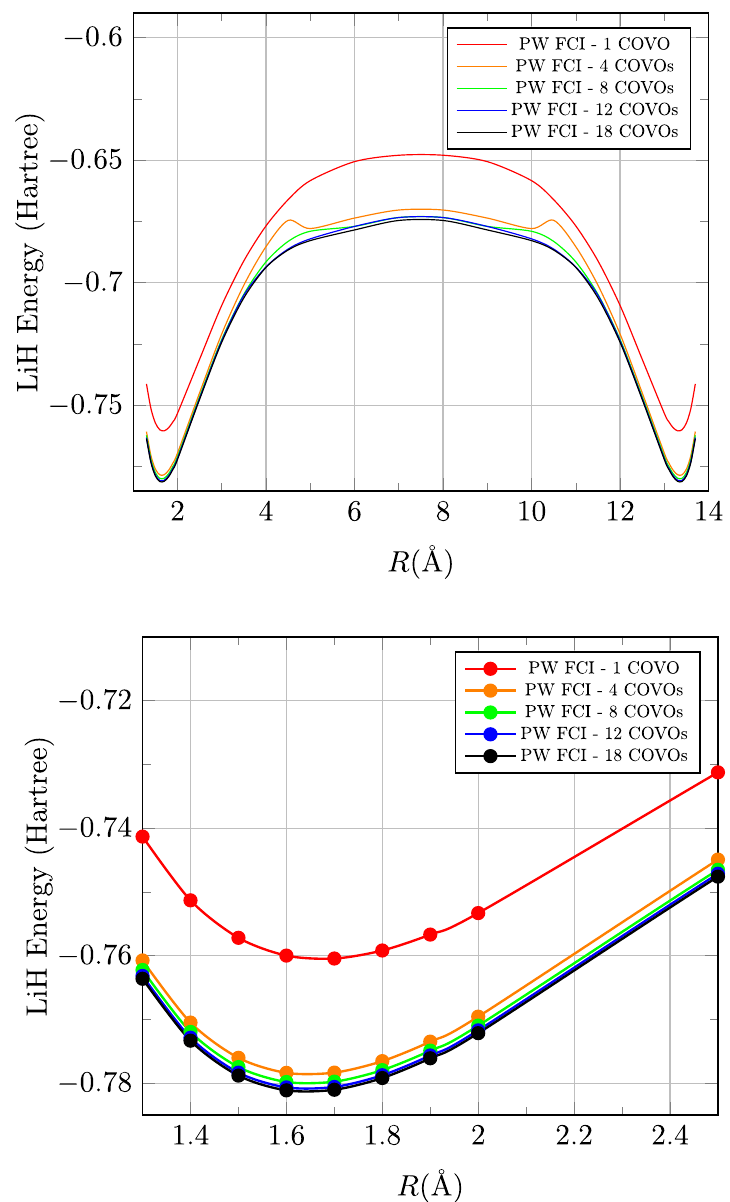
Fig. 1 Total energies as a function of distance from periodic plane-wave FCI calculations for the LiH molecule with 1, 4, 8, 12, and 18 correlation optimized virtual orbitals. The top plot shows energy from R R 13.7 Å, and the bottom plot zooms in near the energy minima at R = simple-cubic supercell (L 15.0 =